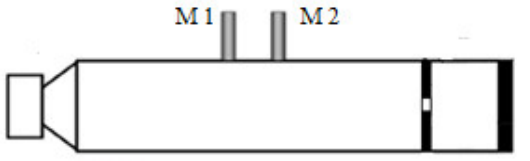
Figure 4. Scheme of measurements by the method of two microphones.